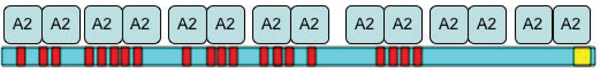
TOG contains multiple hnRNP A2 binding sites. The TOG protein is depicted in cyan with identified HEAT repeats in red and an NTF2 homology domain in yellow. hnRNP A2 dimers ar shown in light blue. Seven subfragments of TOG protein were cloned, each corresponding to a cluster of HEAT repeats or alpha helical domains. Each subfragment of TOG showed binding to hnRNP A2. Binding to TOG subfragments caused dissociation of hnRNP A2 oligomers to dimers.